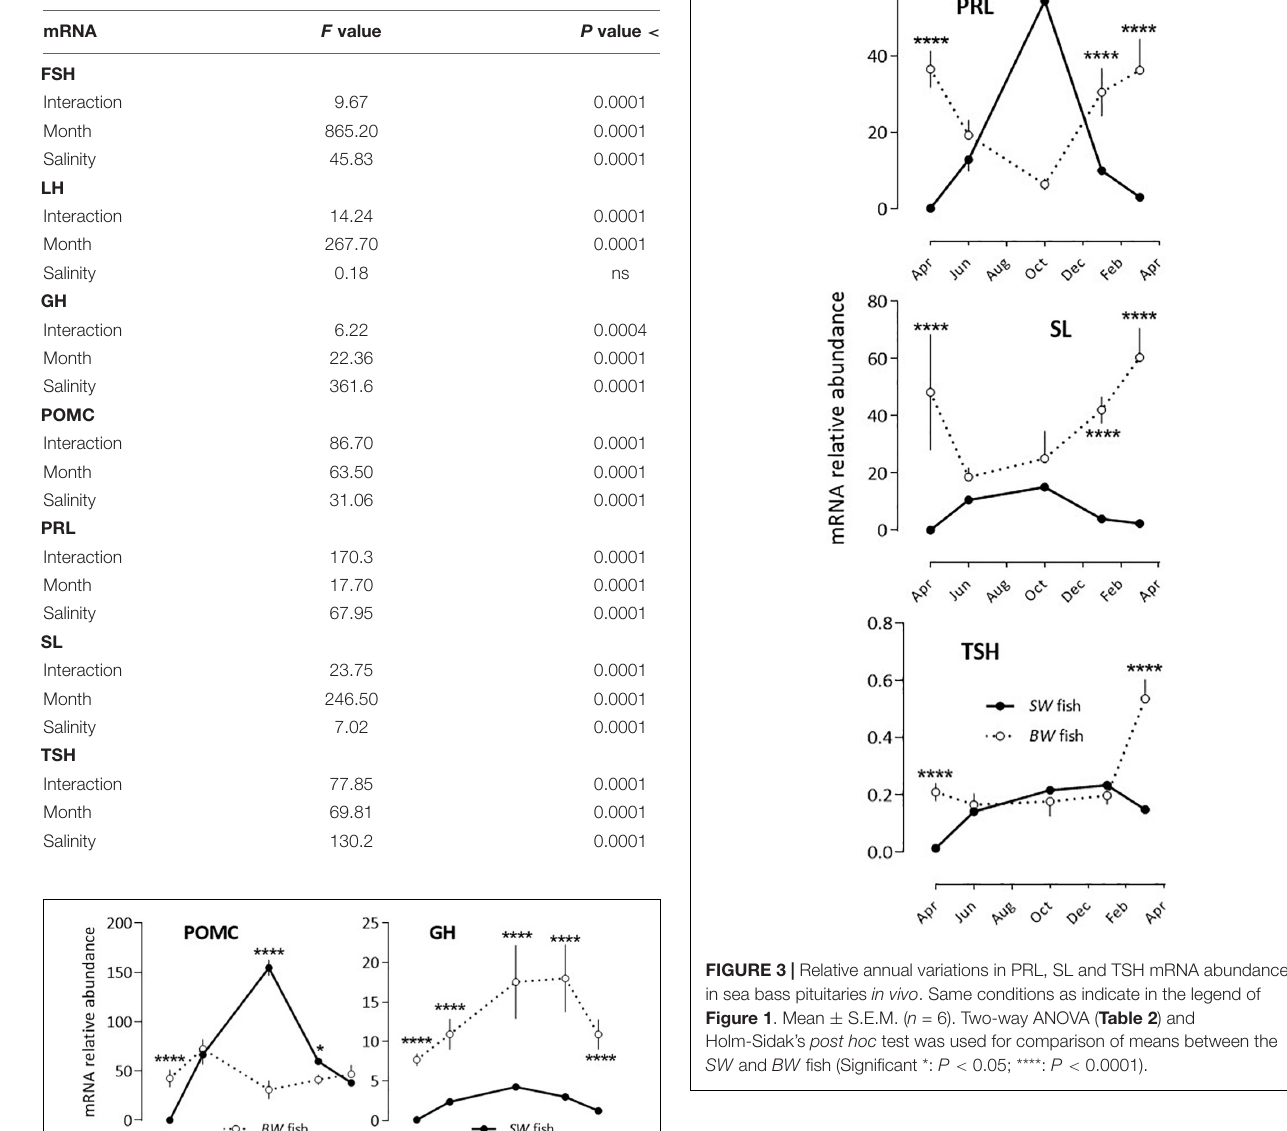
TABLE 2 | Two-way ANOVA data from Figure 1 (Annual variations in the abundance of mRNA of sea bass pituitary hormones).